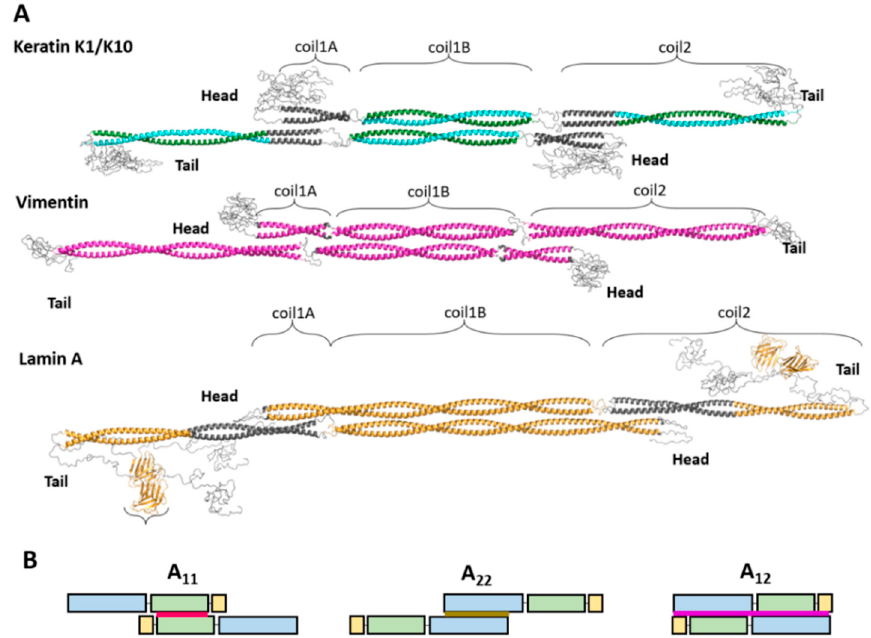
Figure 1. ( A ) Atomic models of the tetramer for representatives of several IF types. For individual dimers, regions with established crystal structures are shown in color. The coiled-coil regions that are a result of in silico modeling using the program CCFold [34] are shown in dark gray. The antiparallel arrangement of two coil1B domains has been resolved crystallographically in each of the three cases. ( B ) Schematic illustration of different lateral dimer alignment modes seen in mature cytoplasmic filaments. Coil1A is shown in yellow, coil1B in green, and coil2 in blue. The A 11 mode (red) is defined by an antiparallel overlap of coil1B regions. A 22 is defined by the antiparallel alignment of coil2. A 12 (purple) corresponds to an antiparallel unstaggered